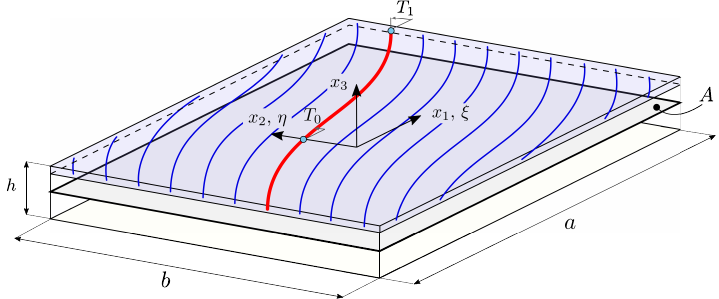
Figure 1. VS plate: reference system and fiber